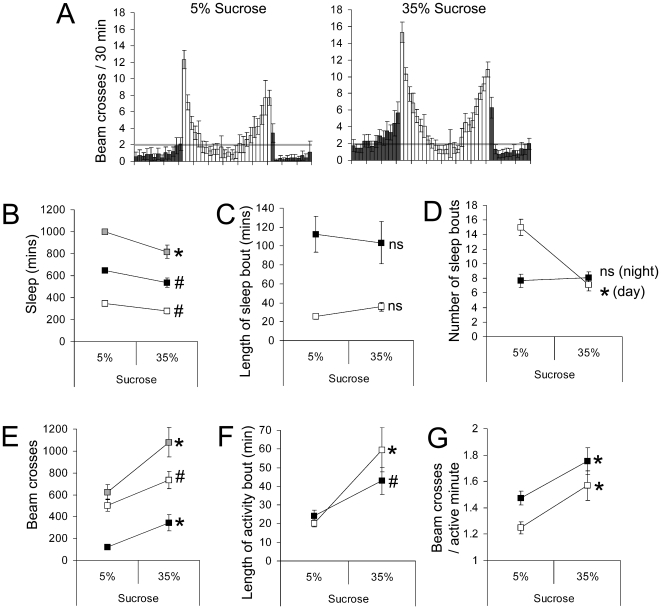
Effect of dietary sucrose on female Drosophila sleep-wake behaviour.Female w1118 flies were fed diets containing different sucrose concentrations and their sleep-wake behaviour monitored for three consecutive days. (A)–(G) Legend as for figure 5. *P<0.01; #P<0.05; n = 15–16 flies for each diet and is representative of two independent trials.